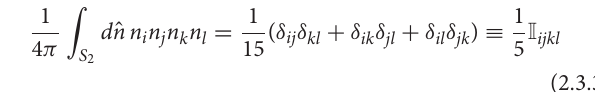
as one fifth of the trace (Tr) of the kurtosis tensor W. The factor